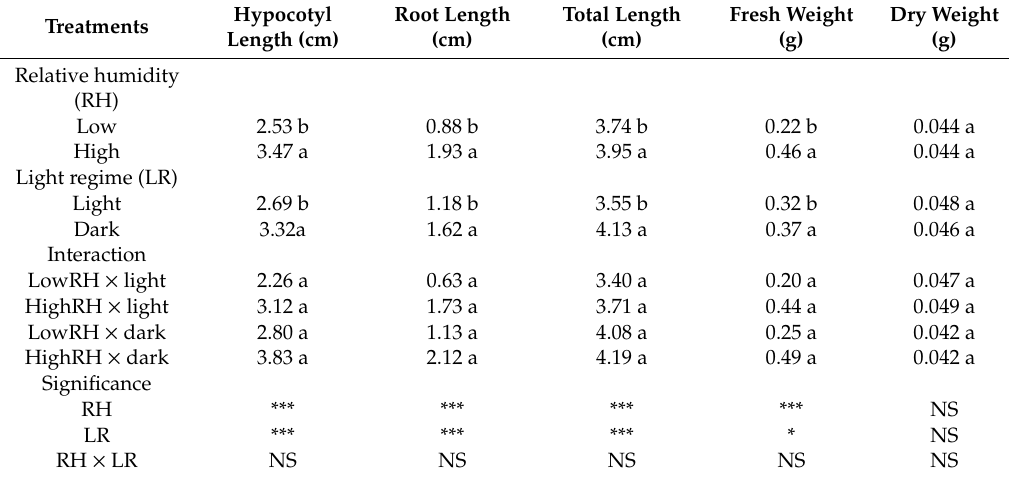
Table 1. Analysis of variance and means comparison for growth traits in mung bean sprouts under low and high RH and light or dark LR as well as under the four di ff erent combinations of RH and LR (LowRH-L; LowRH-D; HighRH-L; HighRH-D). Mean values and statistical significance are shown. NS, *; **, *** Non significant or significant at p ≤ 0.05, 0.01, and 0.001, respectively. Di ff erent letters within each column indicate significant di ff erences, according to Duncan’s multiple-range test ( p ≤